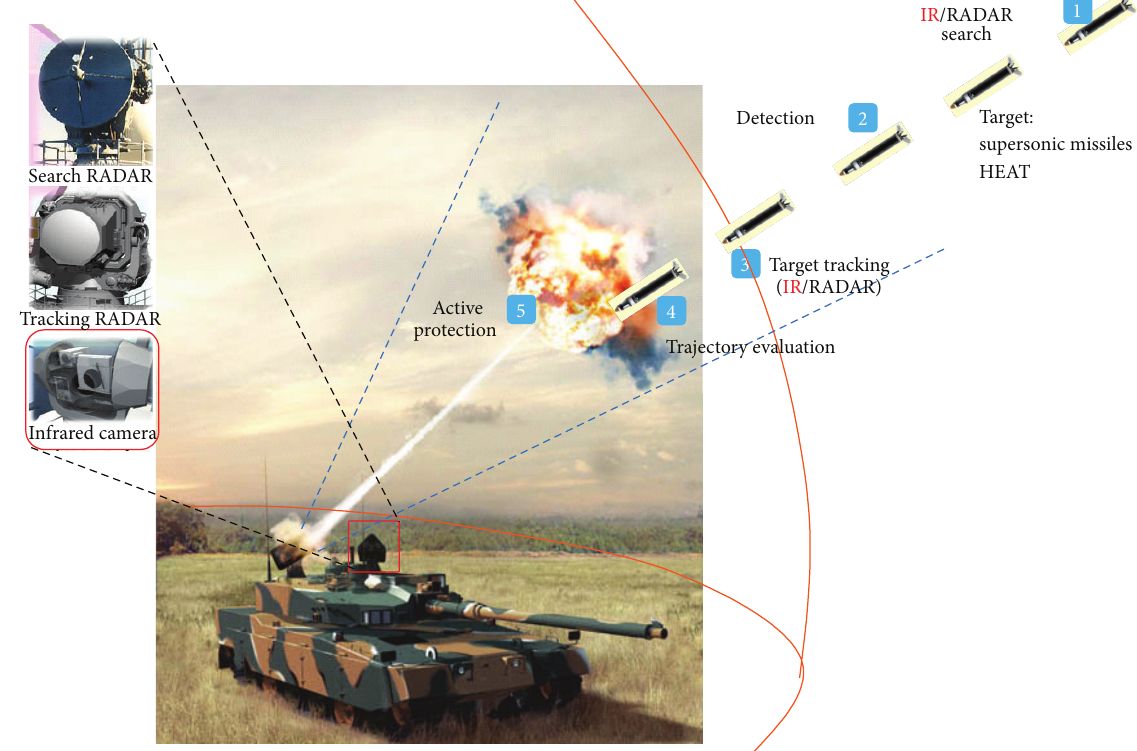
Figure 1: IR-based target detection and tracking in active protection system